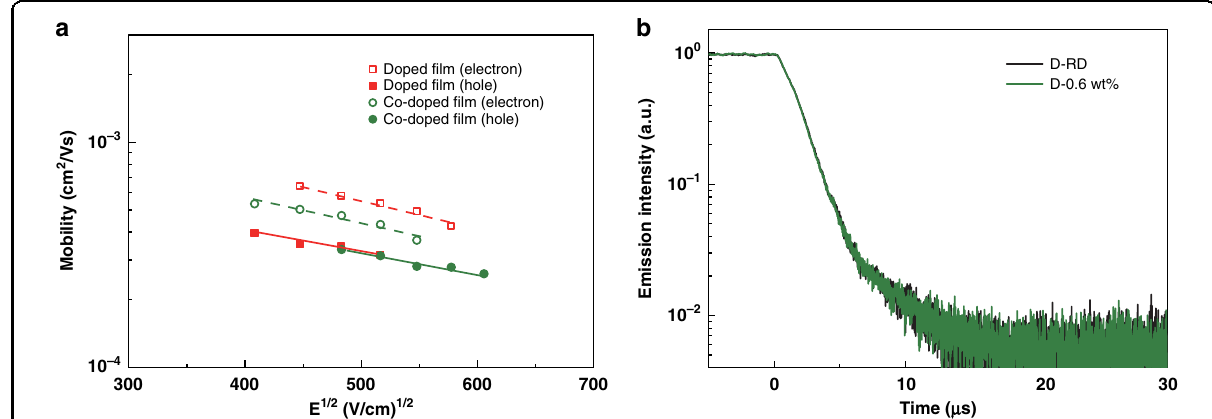
Fig. 13 The carriers transport characteristics and EL decay pro fi les of Ir1 based devices. a Carriers mobilities of doped fi lms and Tb-11 co- doped fi lms. b Transient EL decay pro fi les of reference device and sensitized device. Reprinted from [90], with the permission of Royal Society